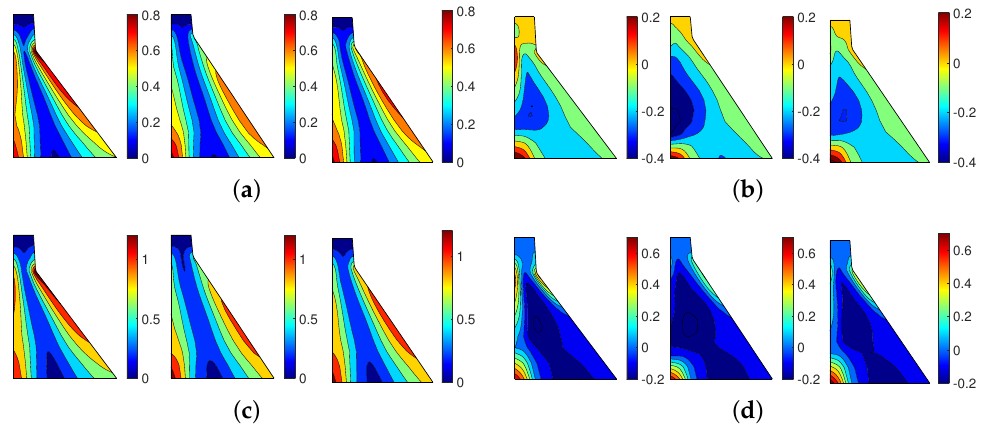
Figure 14. Direct finite element analysis of top three single-constraint surrogate-assisted design candidates (left to right: candidate 1, 2 and 3) based on GM1; Non-concurrent envelope of maximum first principal stresses are shown in MPa. ( a ) RP2500; Dynamic only ( σ heel ( b ) RP2500; Static + Dynamic. ( c ) RP5000; Dynamic only. ( d ) RP5000; Static +